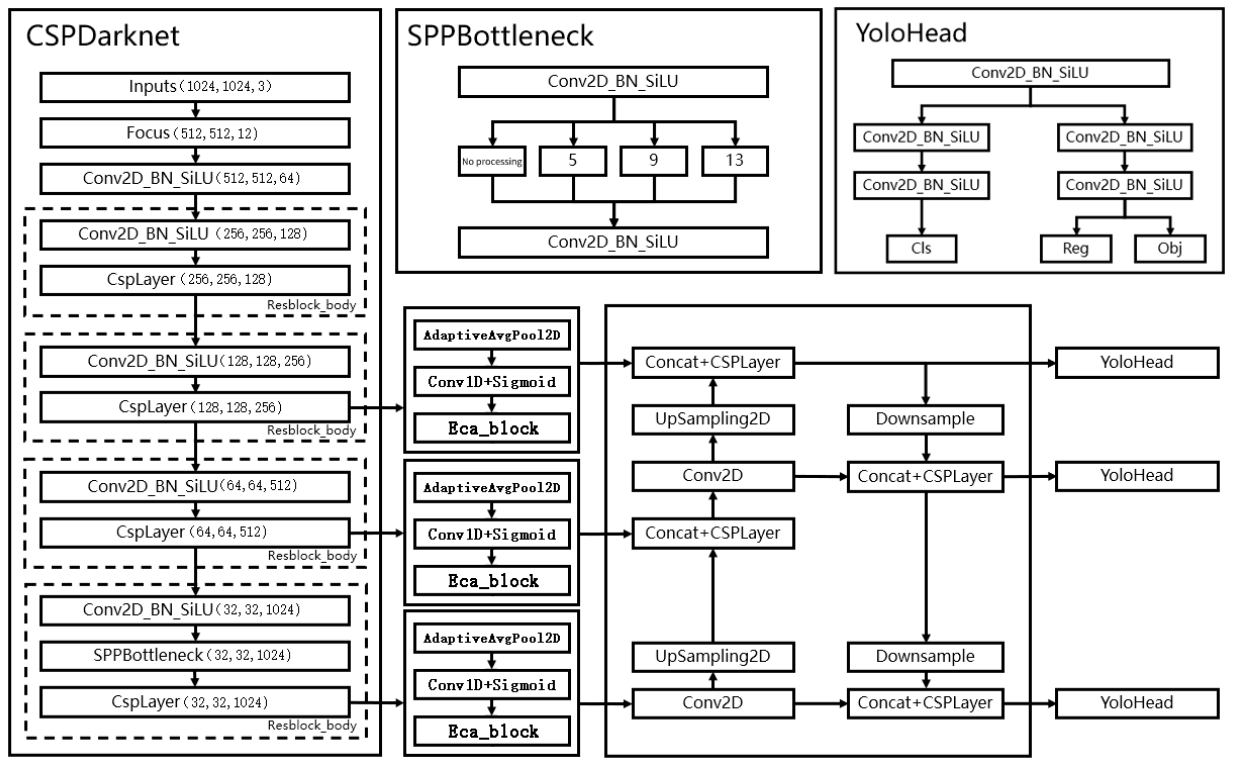
Figure 4. DCE_YOLOX network structure.